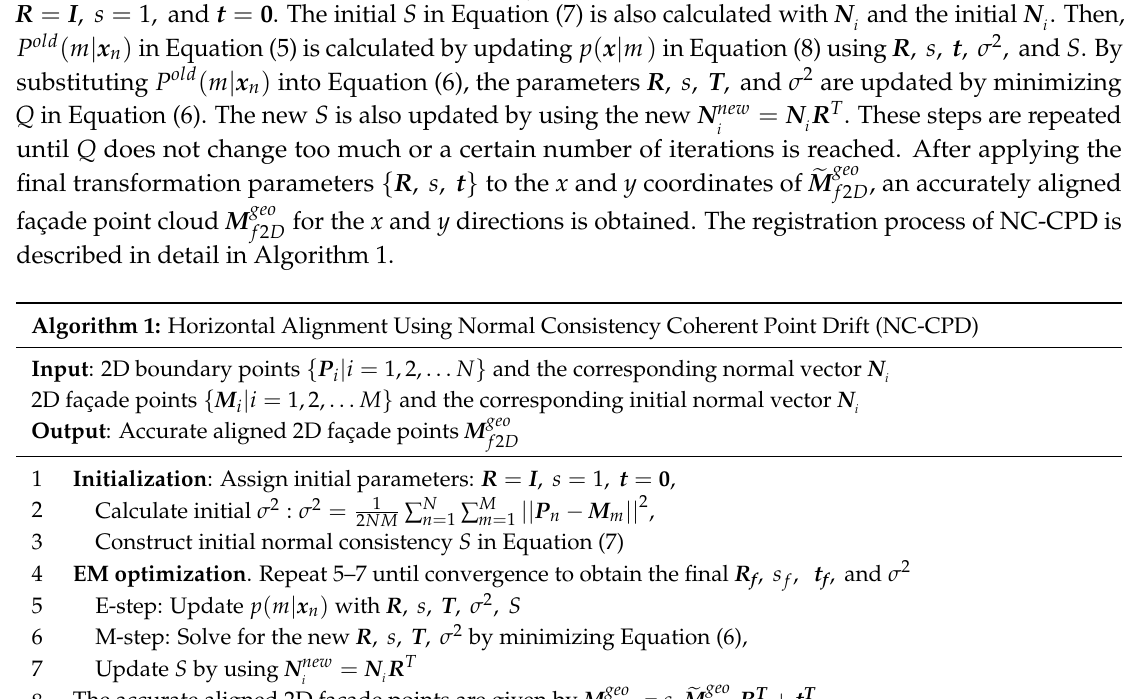
Algorithm 1: Horizontal Alignment Using Normal Consistency Coherent Point Drift (NC-CPD)